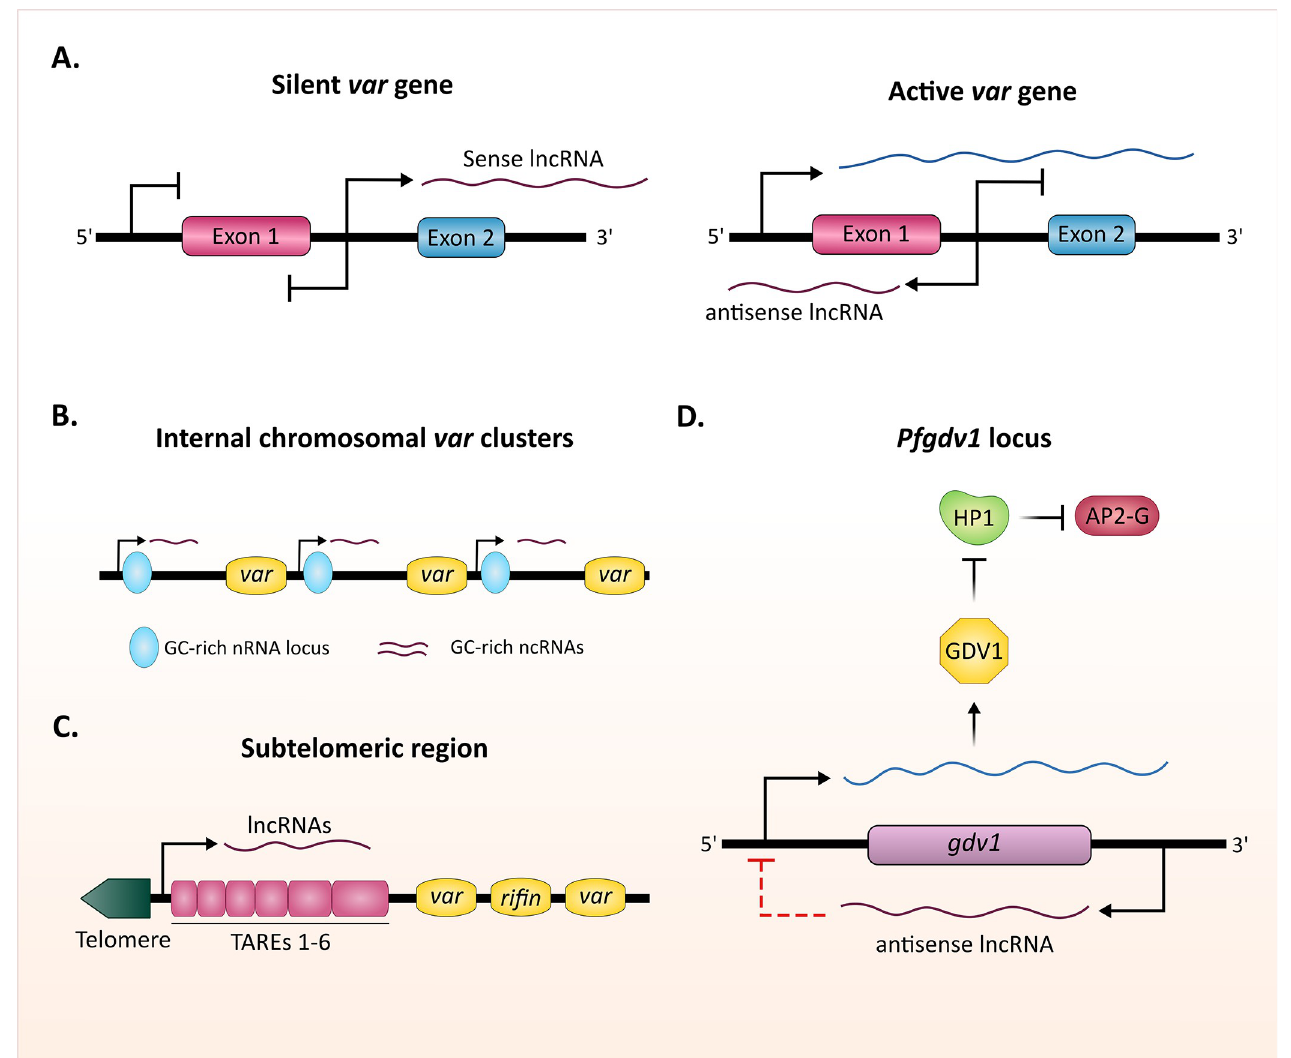
Fig 2. Functionally characterized lncRNAs in P . falciparum . (A) lncRNAs involved in mutually exclusive expression of var genes. Schematic representation of a var gene locus composed of a variable exon 1, bidirectional promoter within the intron, and a conserved exon 2. The upstream var promoter engages in the transcription of the mRNA, while the intronic bidirectional promoter is involved in the production of sense and antisense lncRNA transcripts. The silent var gene transcribes sense ncRNA from the promoter within the intron (left). In the active state of the var gene, RNA polymerase II transcribes both an mRNA in the sense direction and an lncRNA in the antisense direction (right). (B) Intergenic GC-rich ncRNAs transcribed from internal var chromosomal clusters in P . falciparum . These GC-rich ncRNAs are predicted to be transcribed by RNA polymerase III. (C) Schematic representation of P . falciparum telomere and TAREs and subtelomeric gene families. (D) lncRNA’s involvement in sexual commitment. Sexual commitment in Plasmodium is regulated by GDV1, whose expression is antagonistically regulated by its antisense lncRNA. Once expressed, GDV1 reverses HP1-dependent silencing of AP2-G and inhibits sexual commitment. GDV1, gametocyte development 1; HP1, heterochromatin protein 1; lncRNA, long ncRNA; ncRNA, noncoding RNA; TARE, telomere- associated